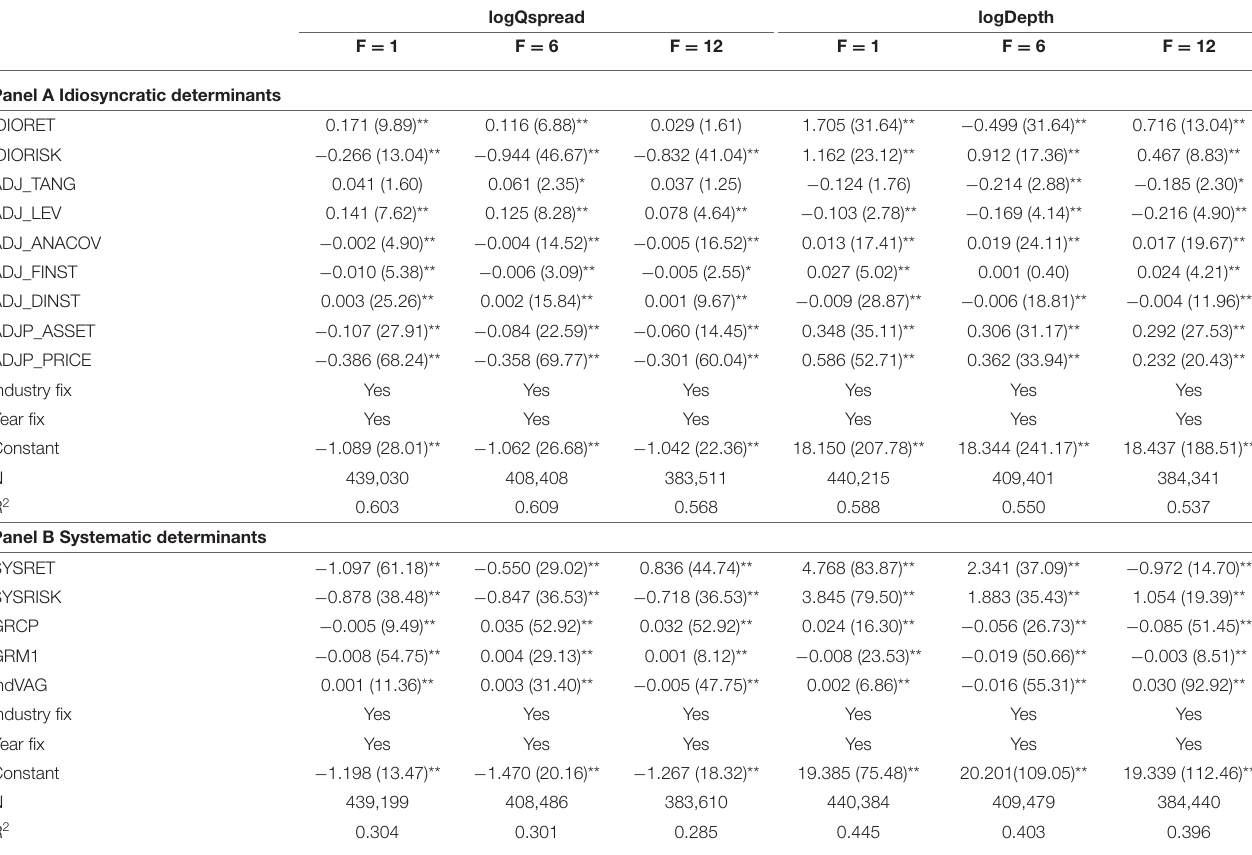
TABLE 6 | Future impact of variables on quoted relative bid–ask spread and trading